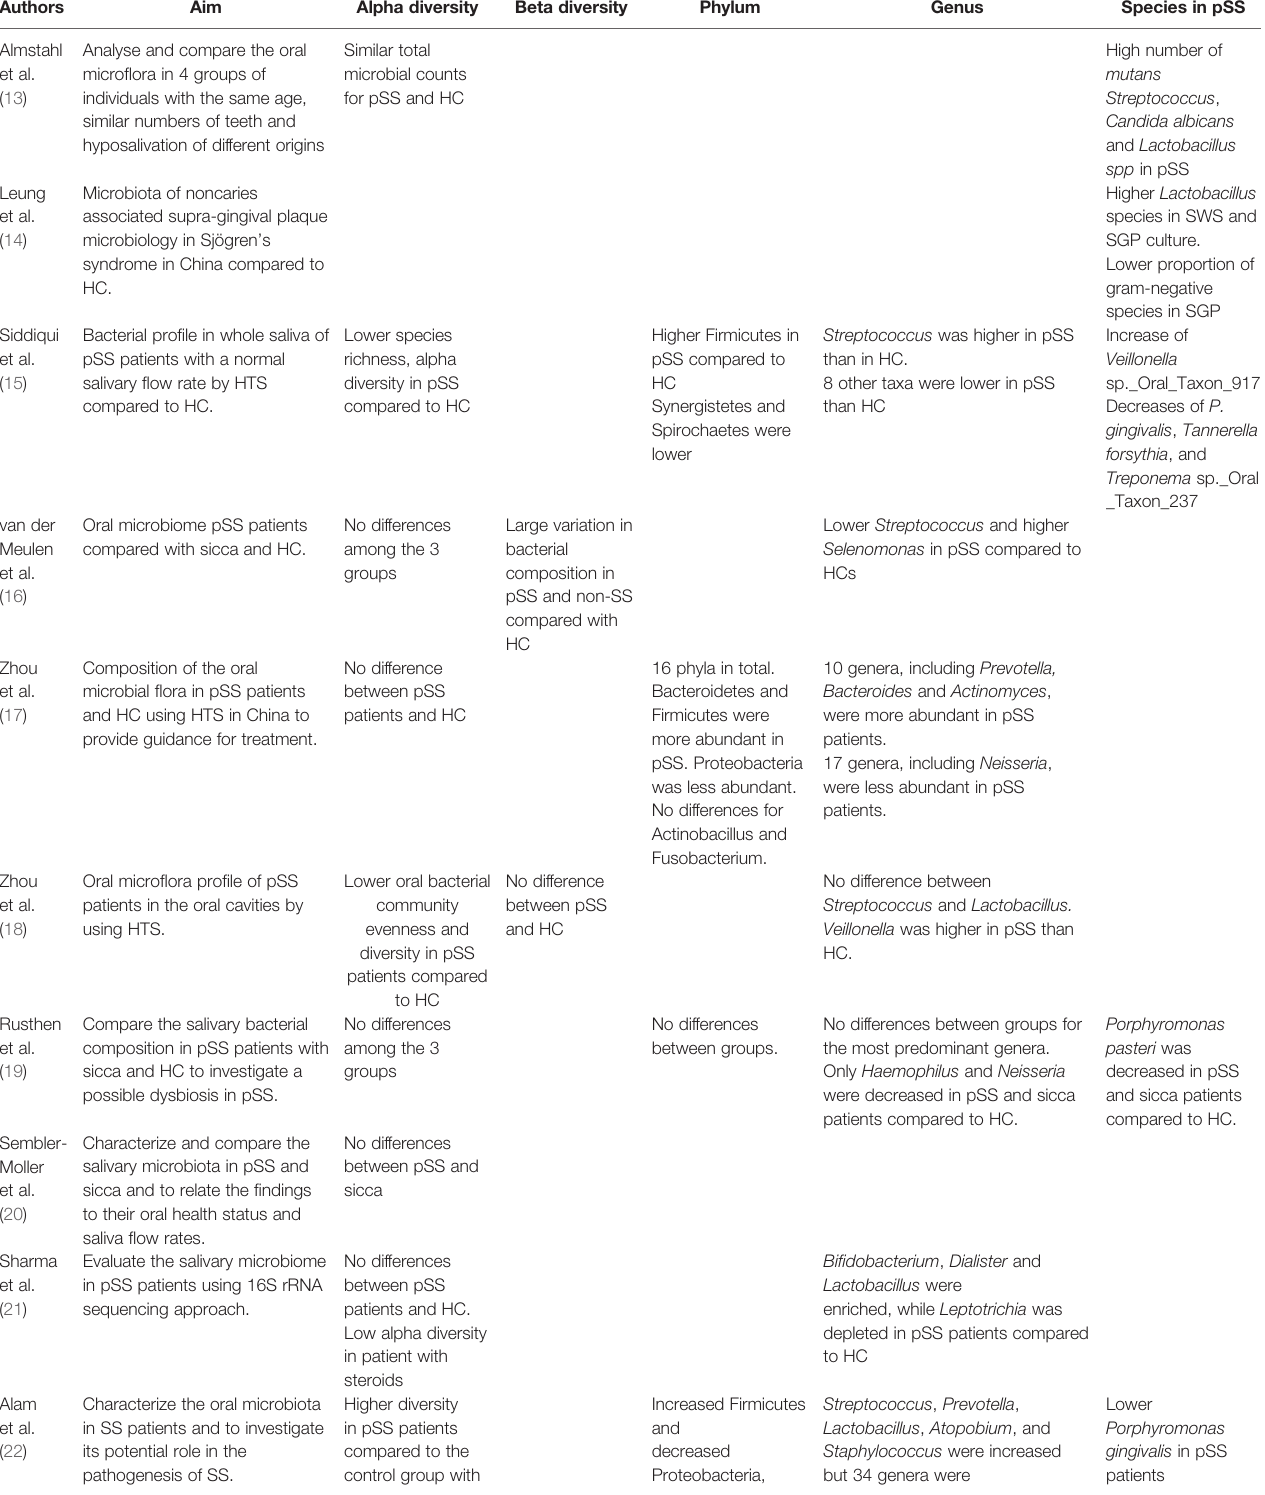
TABLE 3 | Analysis of the results of the included studies relying on saliva samples in pSS compared to HC and